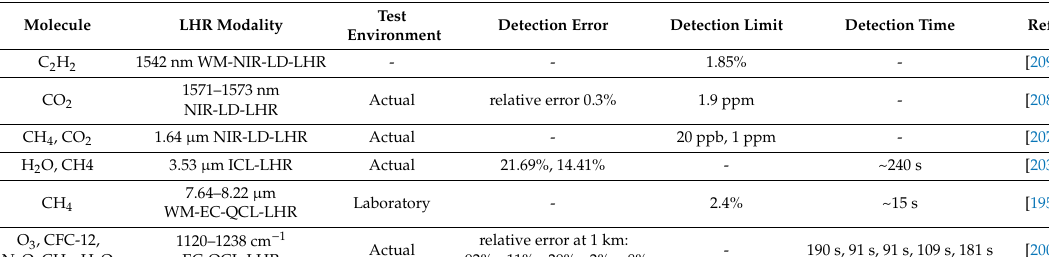
Table 6. Detection error and detection limit of passive laser heterodyne spectrum.